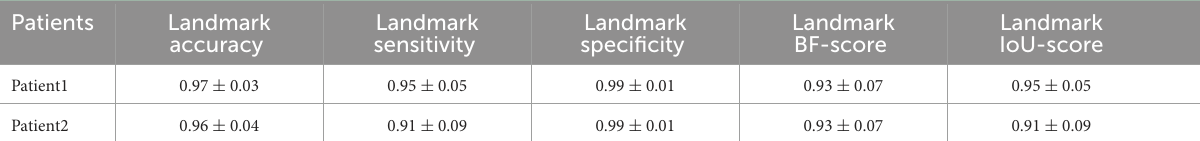
TABLE 6 Measured accuracy, sensitivity, specificity, BF-score, and IoU-score for the landmark detection including the aorta, iliac, celiac, and renal arteries on CT images of the two challenging cases.